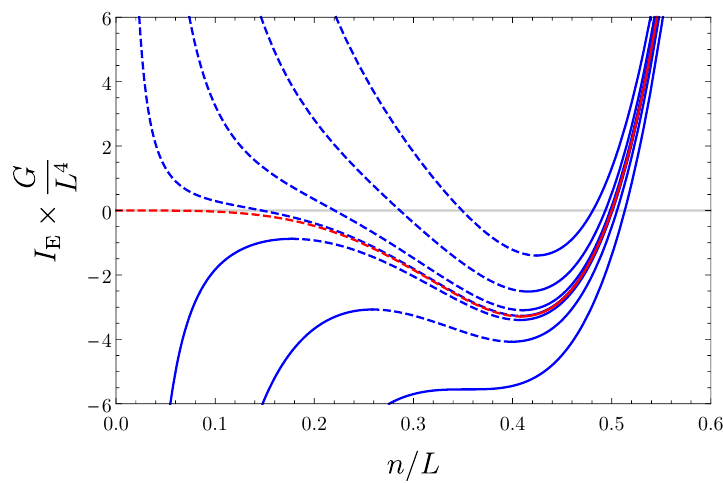
Figure 10 . Euclidean on-shell action for B = CP 2 NUT solutions. The red curve corresponds to the Einstein gravity result, while the blue curves correspond to (cid:24) + (cid:16) = 27 = 256 ; 27 = 256 (cid:0) 1 = 10 ; 27 = 256 (cid:0) 10 = 95 ; (cid:0) 10 (cid:0) 3 ; (cid:0) 10 (cid:0) 2 ; (cid:0) 4 (cid:2) 10 (cid:0) 2 and (cid:0) 10 (cid:0) 1 (bottom to top through a vertical slice). The dashed portions of the curves indicate solutions with negative mass, though there is no pathology associated with these solutions in this